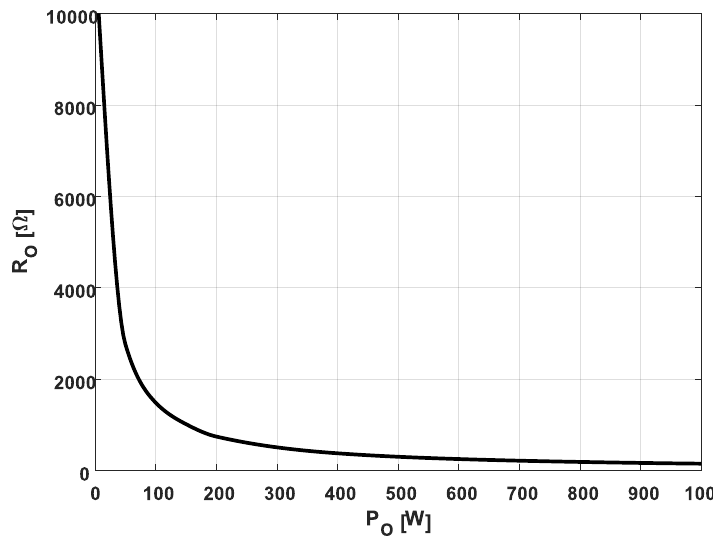
(32) The measured static output voltage versus load power curve was derived in [27] and is reproduced in Figure 7. According to (29) and (31), there is